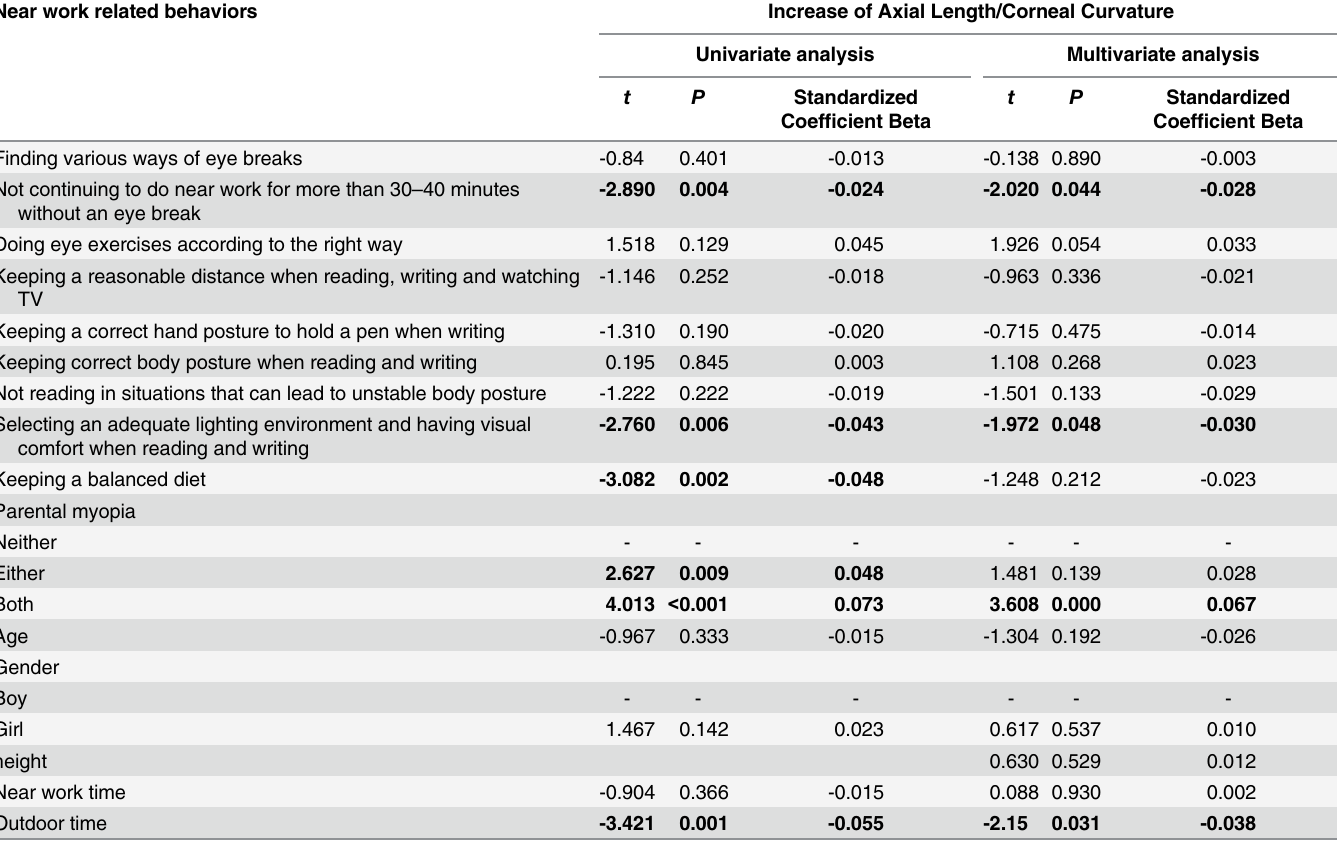
Table 4. Near work related behaviors associated with axial increase of length/corneal curvature within one year in students of grade 1 to 4 in